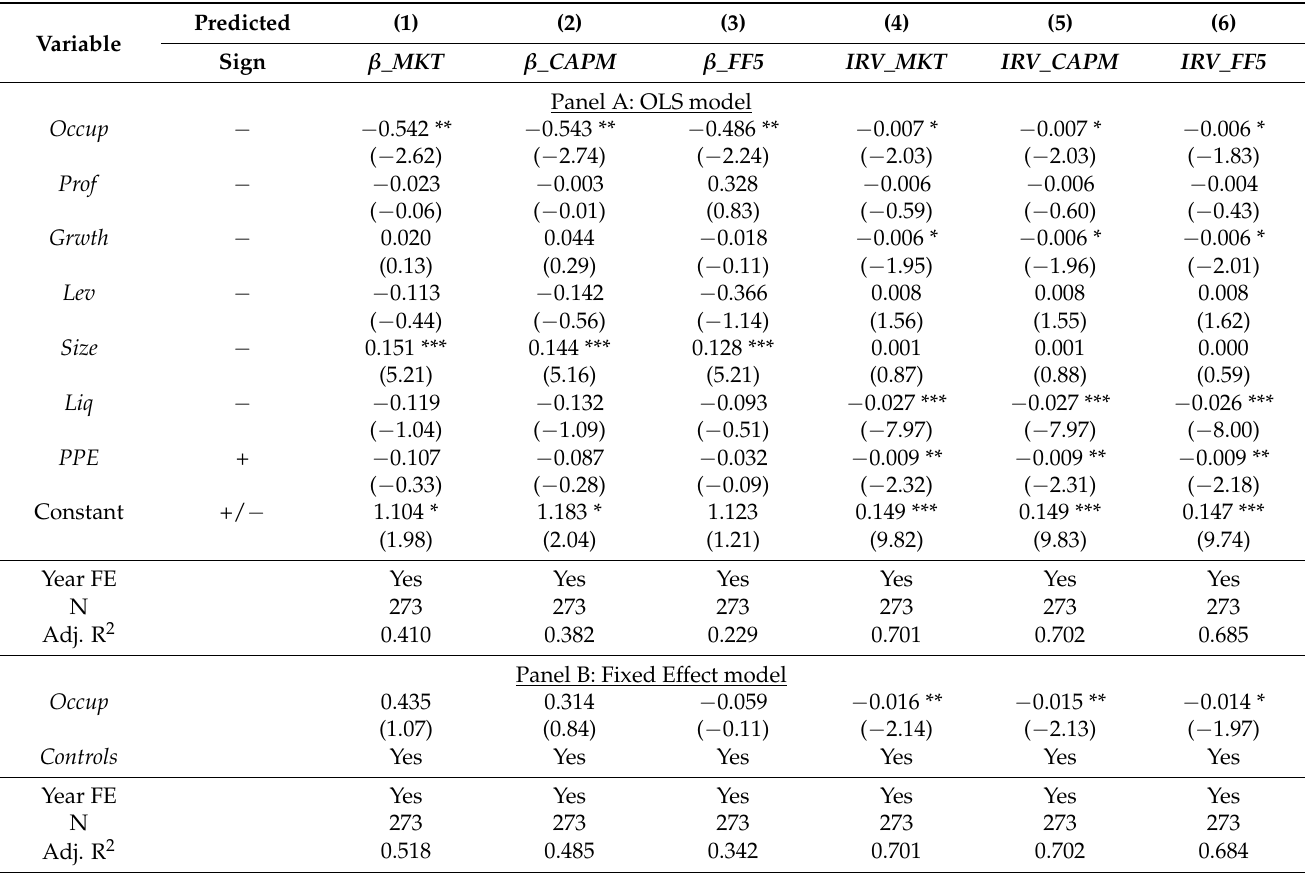
Table 2. Baseline